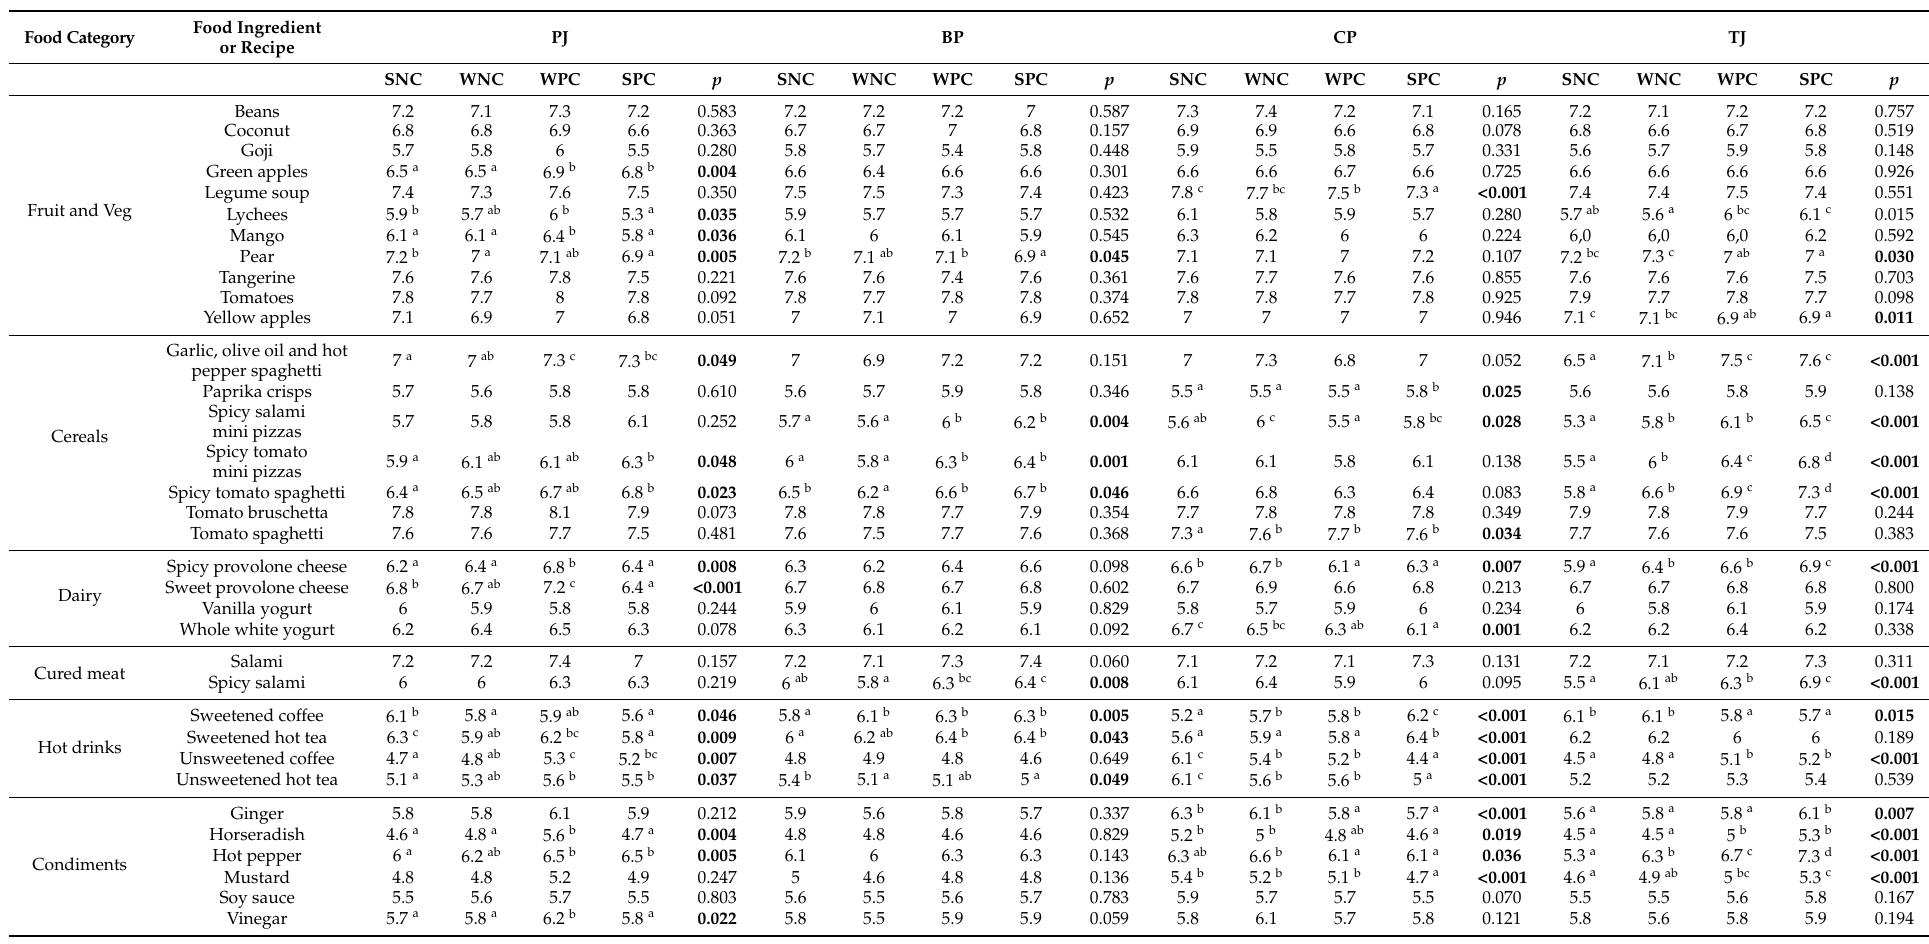
Table 3. Average stated liking scores for 40 food products presented in clusters (SNC = Strong Negative Correlation, WNC = Weak Negative Correlation, WPC = Weak Positive Correlation, and SPC = Strong Positive Correlation) for pear juice (PJ), bean pur é e (BP), chocolate pudding (CP), and tomato juice (TJ). Significant